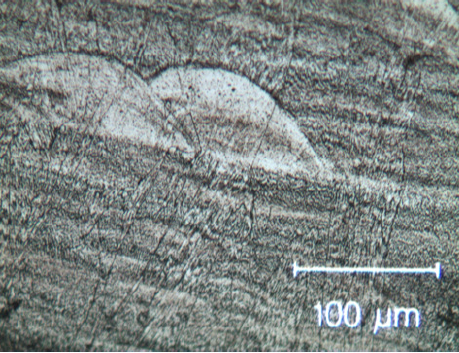
Figure 3. Optical micrographs of the as-built SLM HEA observed in transversal section with melt pots due to the laser beam.